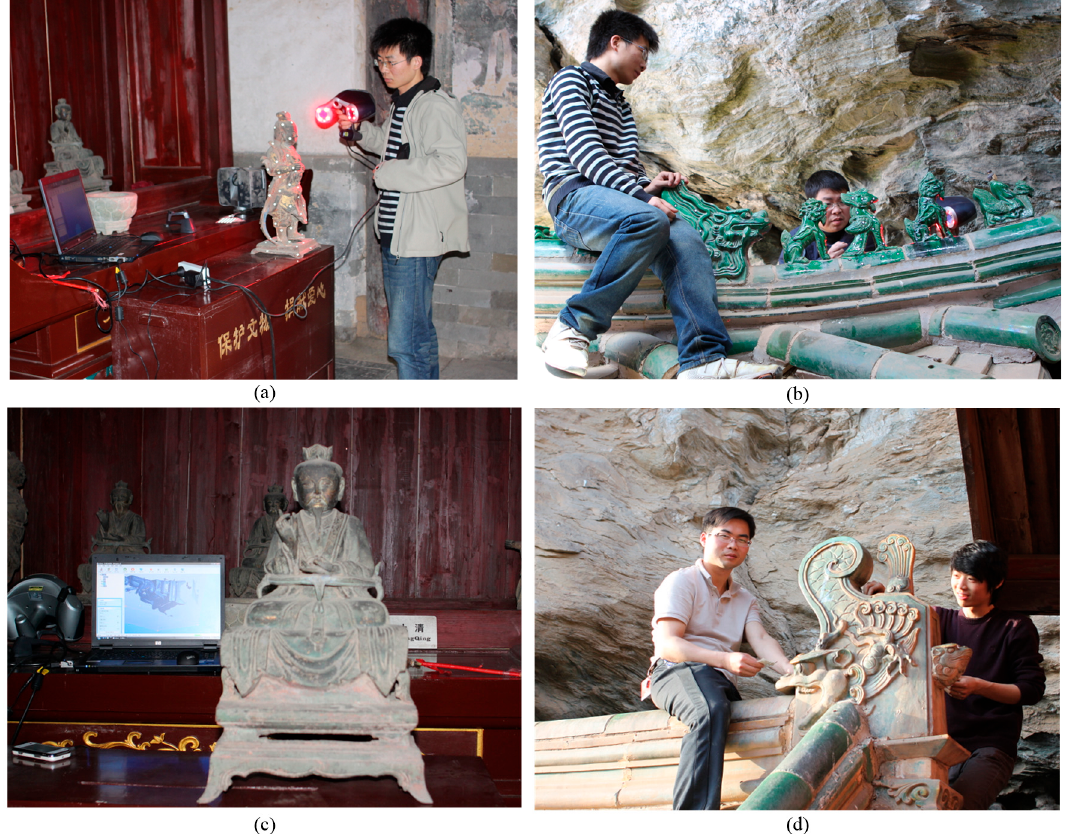
Figure 7. 3D data collection for some components with the handheld scanner. ( a ) Small statue scanning; ( b ) rows of horned beast scanning; ( c ) large statue scanning; ( d ) corner horned beast scanning.